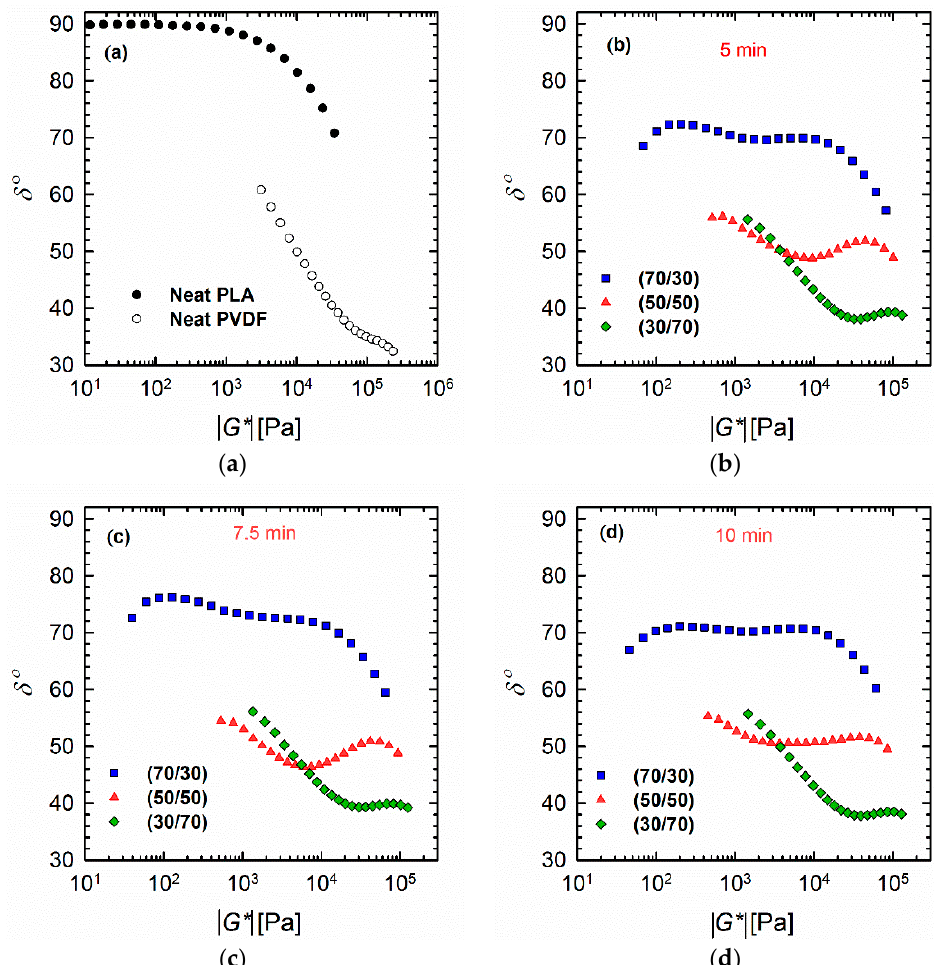
Figure 4. Van Gurp–Palmen plots of ( a ) neat polymers and ( b – d ) 70/30, 50/50, and 30/70 PLA/PVDF blends processed for ( b ) 5, ( c ) 7.5, and ( d ) 10 min at 200 °C.